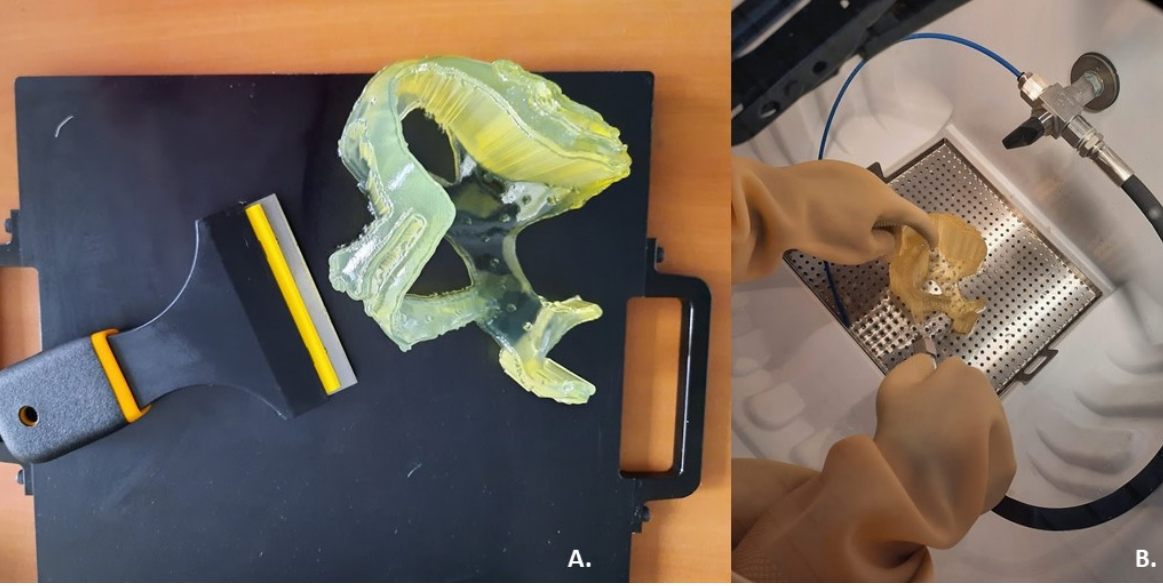
Figure 5. Post-printing steps: ( A ) Removal of the prototype from the 3D printer plate; ( B ) Cleaning of support material using a high-pressure water jet.